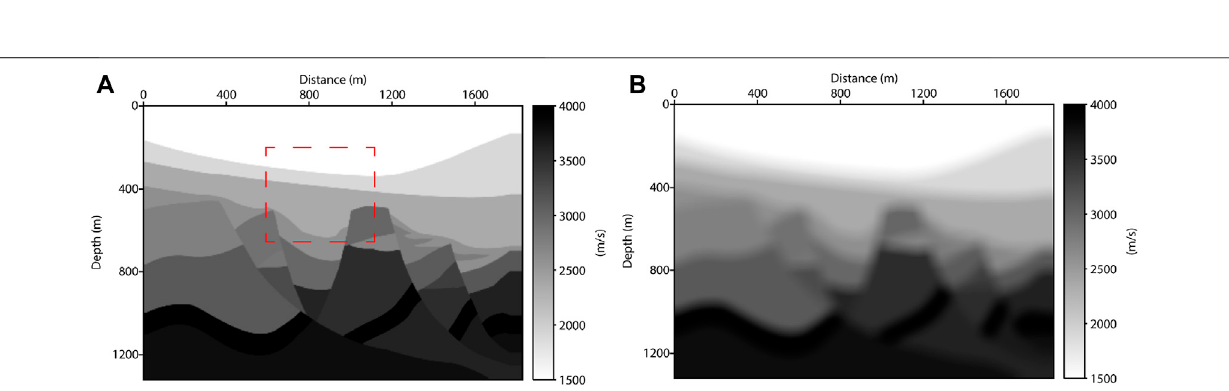
Frontiers in Earth Science |